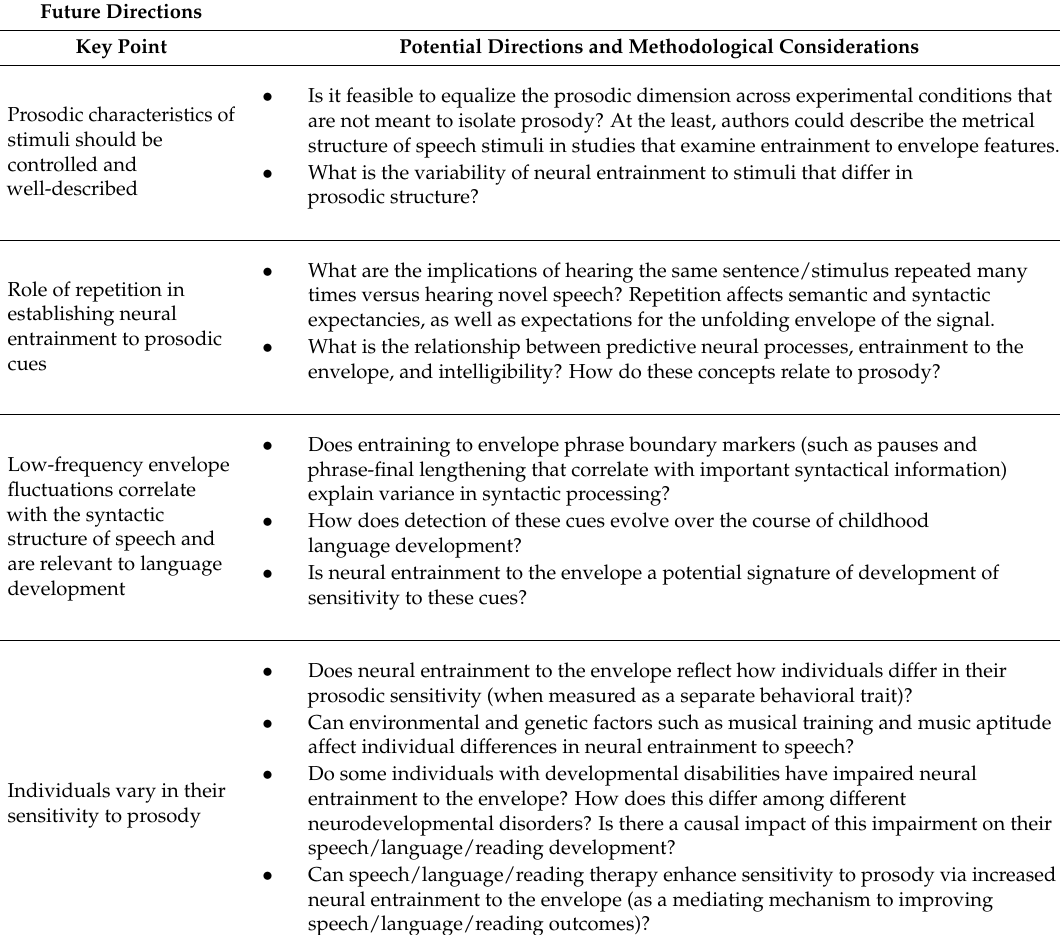
Table 2. Potential future directions including key points and methodological